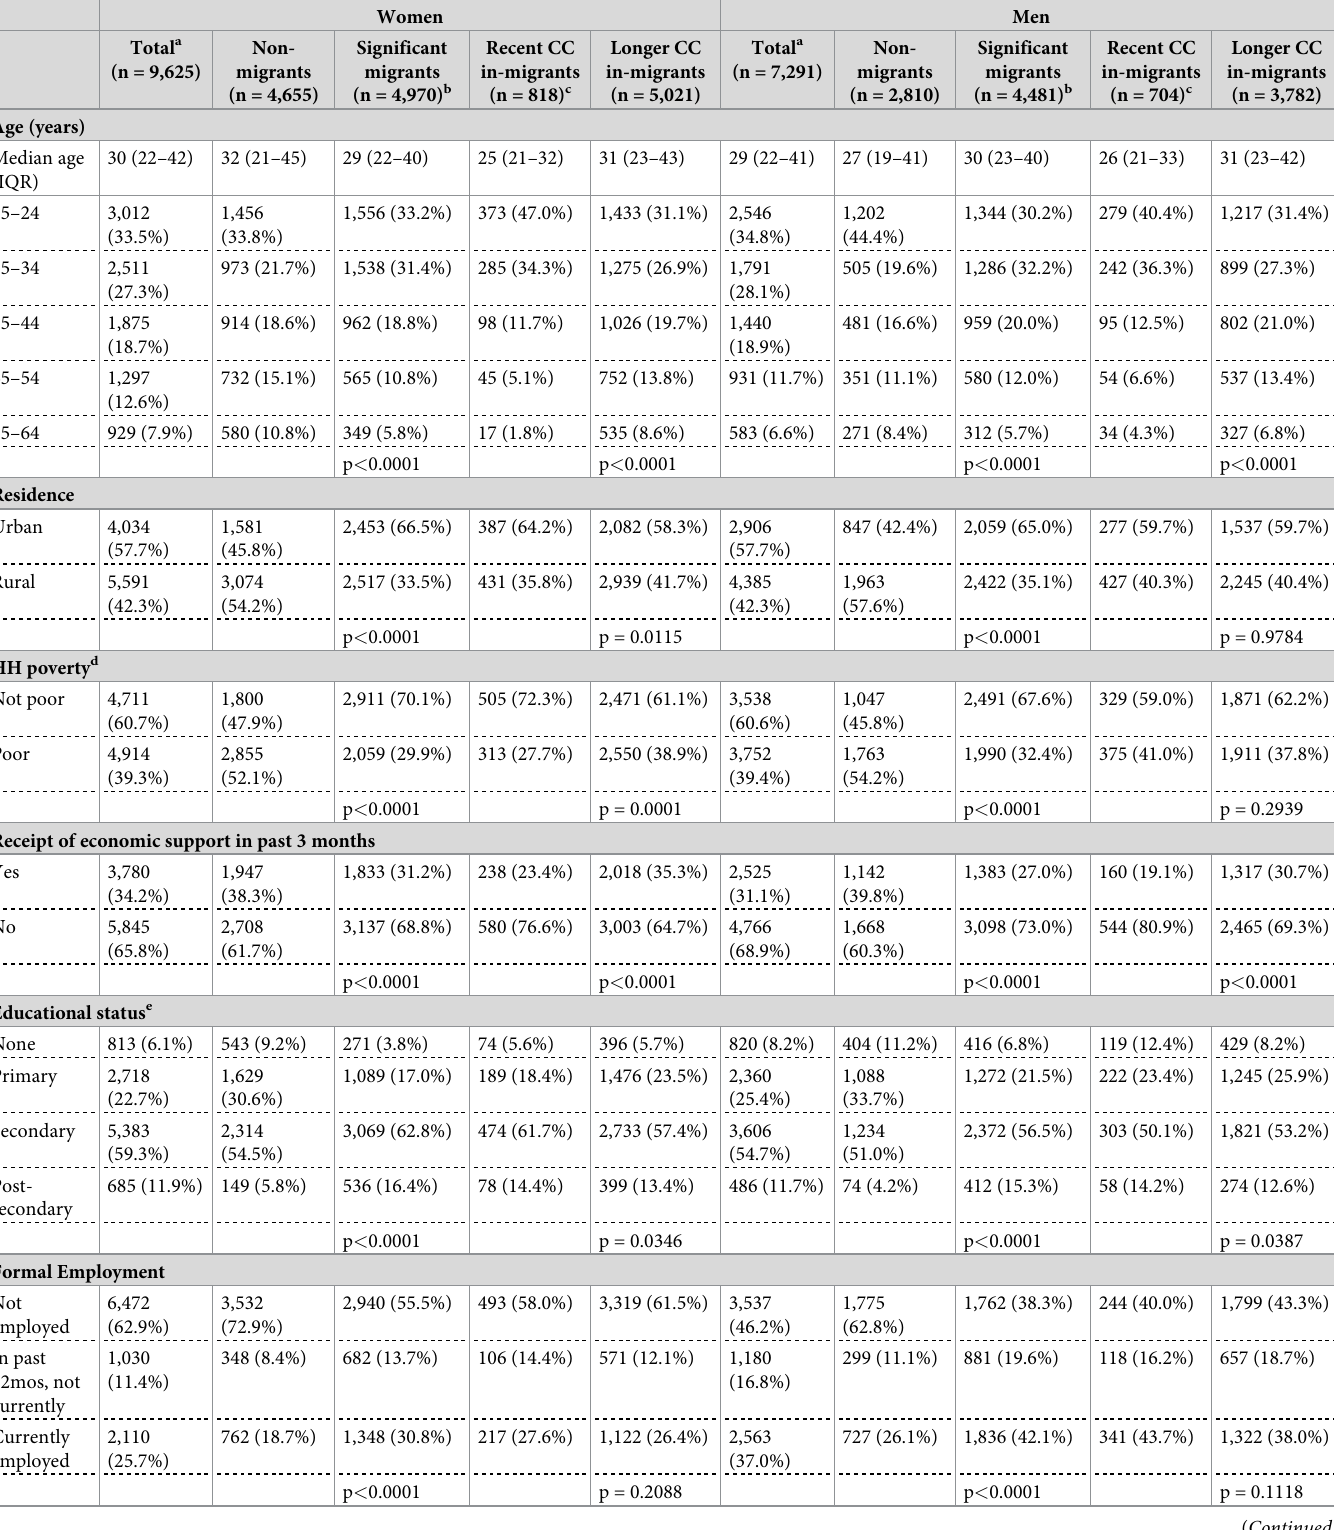
Table 1. Characteristics of adults aged 15–64 years who participated in the 2017 Namibia opulation-based HIV Impact Assessment